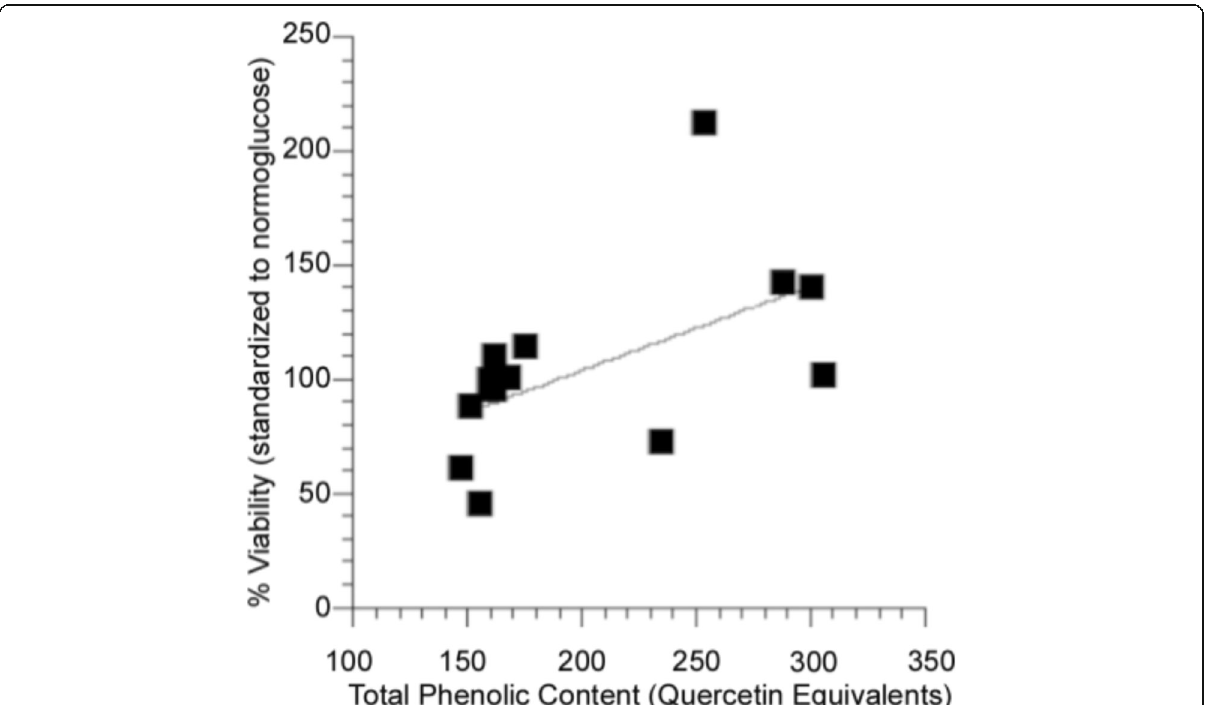
Fig. 6 Regression analysis of total phenolic content of of P. mariana extracts with respect to bioactivity in PC12-AC in high glucose media. The trend shows that as phenolic content increases the percent viability increases ( p ≤ 0.05, n =